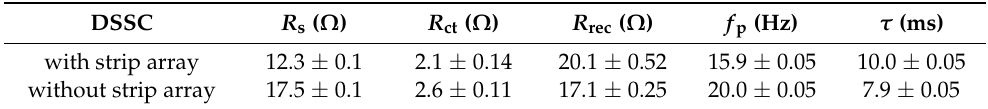
Table 2. Averaged series resistances ( R s , R ct , and R ec ), averaged peak frequencies ( f p ) of Bode plots, and averaged electron lifetimes ( τ ) for DSSCs with and without a TiO 2 strip